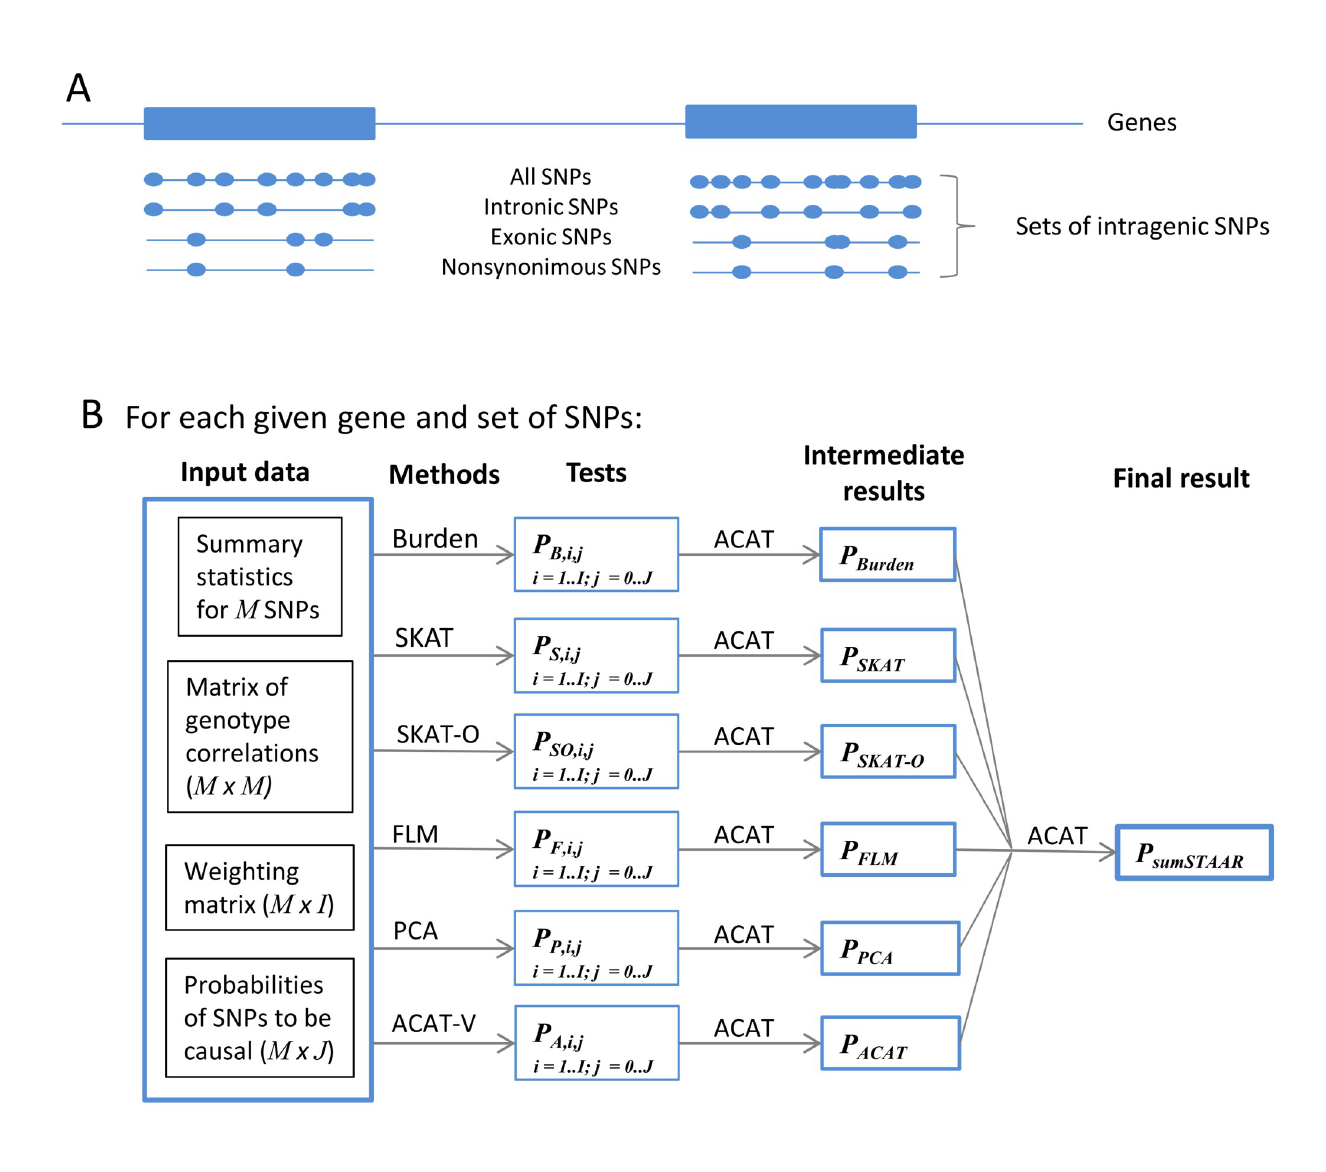
Fig 1. Workflow schematic. (A) Each set of SNPs (all, non-coding, exonic, nonsynonymous and others) is analyzed separately. (B) Input data for sumFREGAT include GWAS summary statistics (p-values and effect sizes), correlations between genotypes calculated using the same or reference sample, the matrix of weighting functions defined by the parameters of the beta distribution, the probabilities of SNPs being causal (e.g., estimated using different functional annotations http://favor. genohub.org/). The list of methods can comprise an arbitrary subset of BT, SKAT, SKAT-O, PCA, FLM, and ACAT-V. All methods use summary statistics as input. For each method, region-based association analysis is repeatedly performed using different combinations of the weighting functions ( i 2 [1, I ]) and probabilities of SNPs being causal ( j 2 [0, J ]). ACAT is used for combining the p-values obtained by each method under different weighting functions and probabilities, and then for combining the results obtained by various